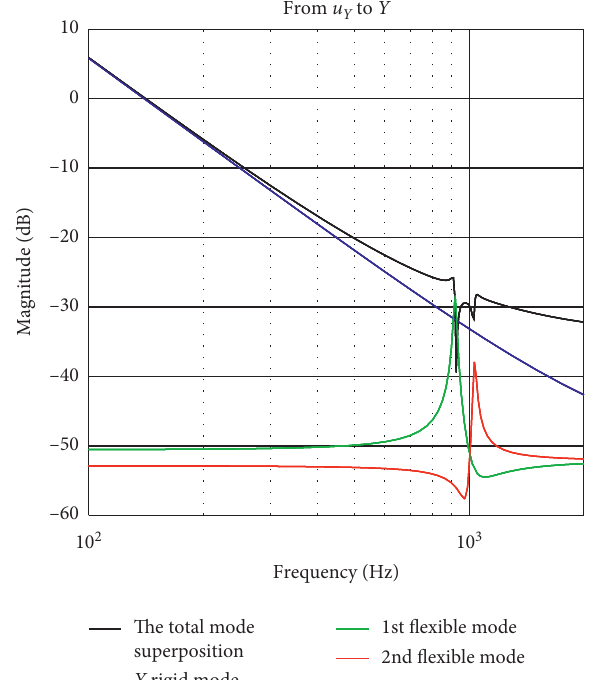
Figure 5: Mode superposition of the y